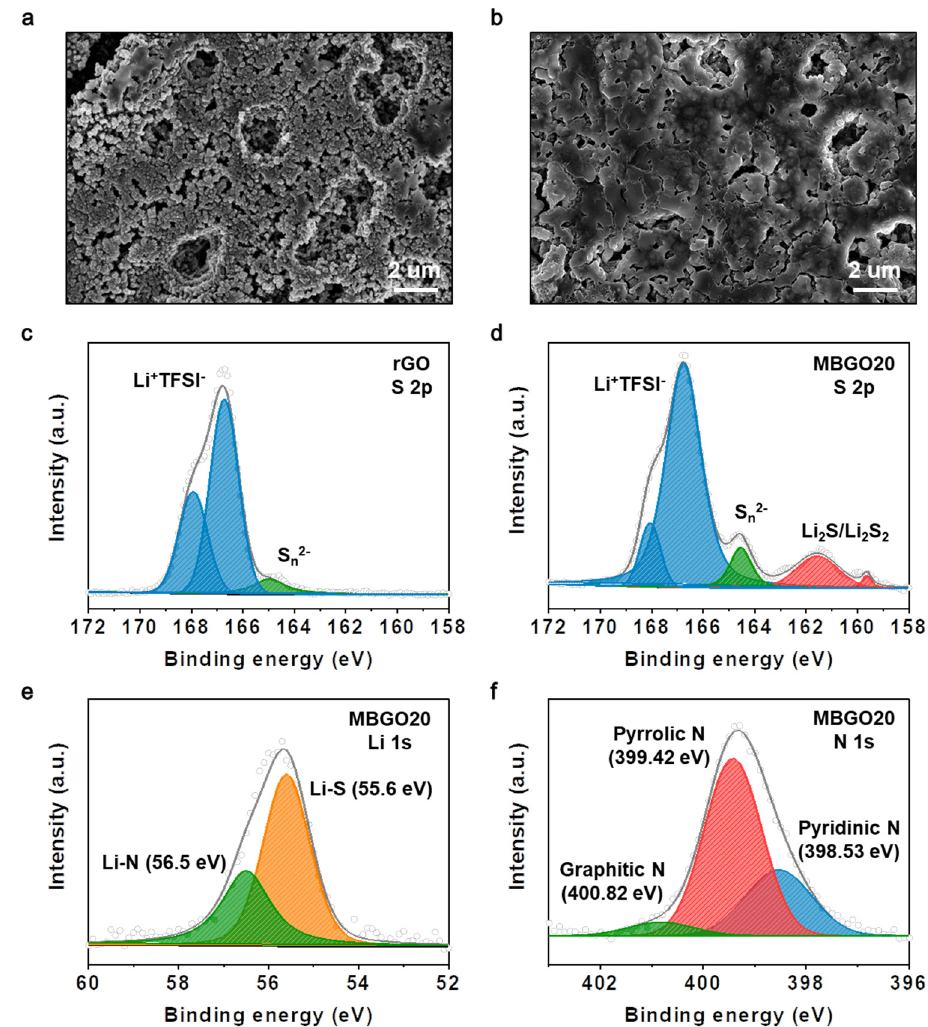
Figure 5. SEM images of the lithium metal anode surface of ( a ) rGO and ( b ) MBGO20 cathode after 100 cycles. High–resolution XPS spectra of ( c ) S 2p of rGO cathode and ( d ) S 2p, ( e ) Li 1s and ( f ) N 1s of MBGO20 cathode after cycling.